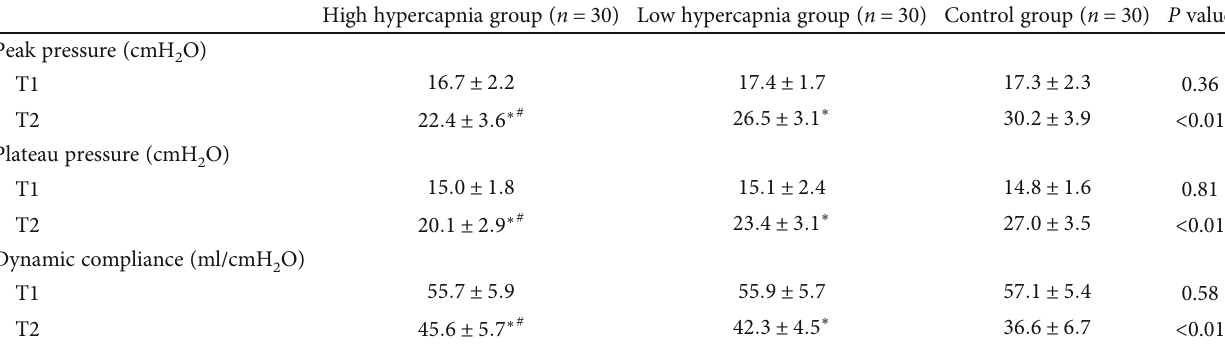
Table 2: The ventilatory parameters in the three groups at T1 and T2.